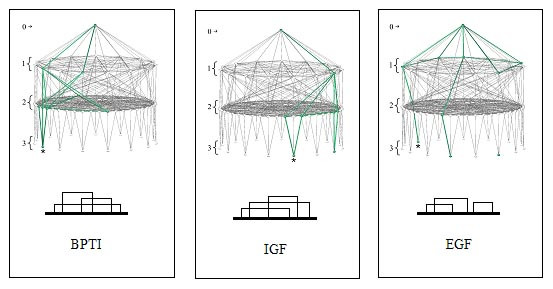
The oxidative folding pathways of bovine pancreatic trypsin inhibitor (BPTI), insulin-like growth factor (IGF) and epidermal growth factor (EGF). The disulfide connectivity of the intermediates is sumarized in Table 2. Asterisk denotes the native state.